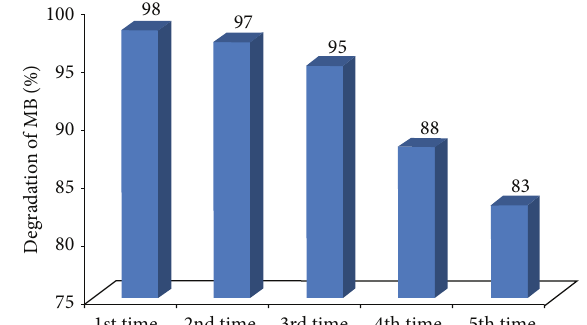
Figure 10: Recyclability of TiO 2 /AC was carried out for 5 cycles